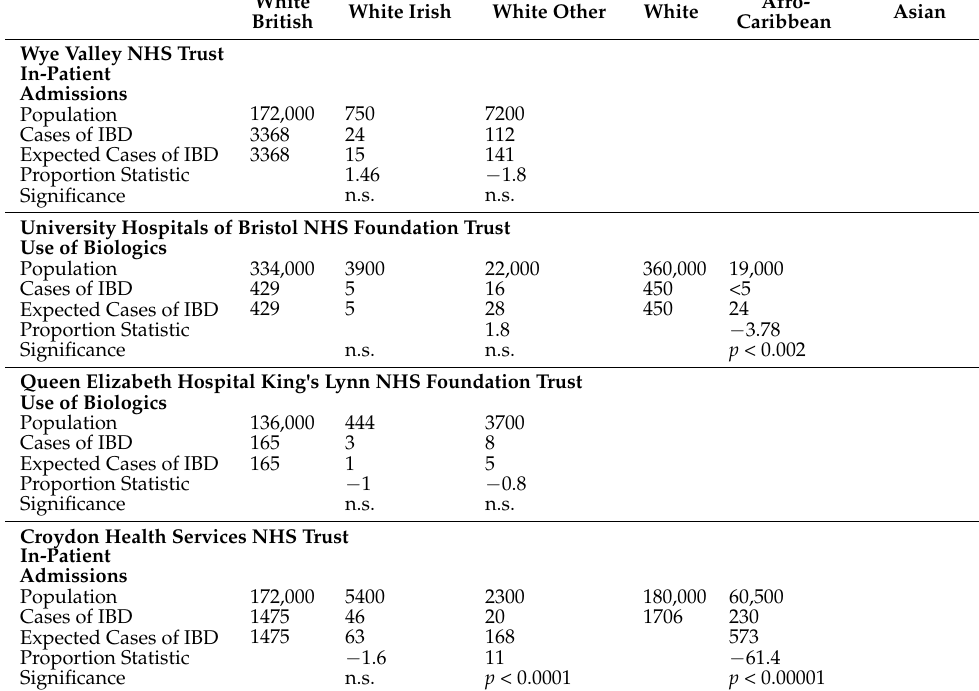
Table 1. Hospital admission statistics and biologic use in the management of inflammatory bowel disease between 2014–2018 in selected NHS trusts with significant Black and Ethnic Minority (BEM) populations in